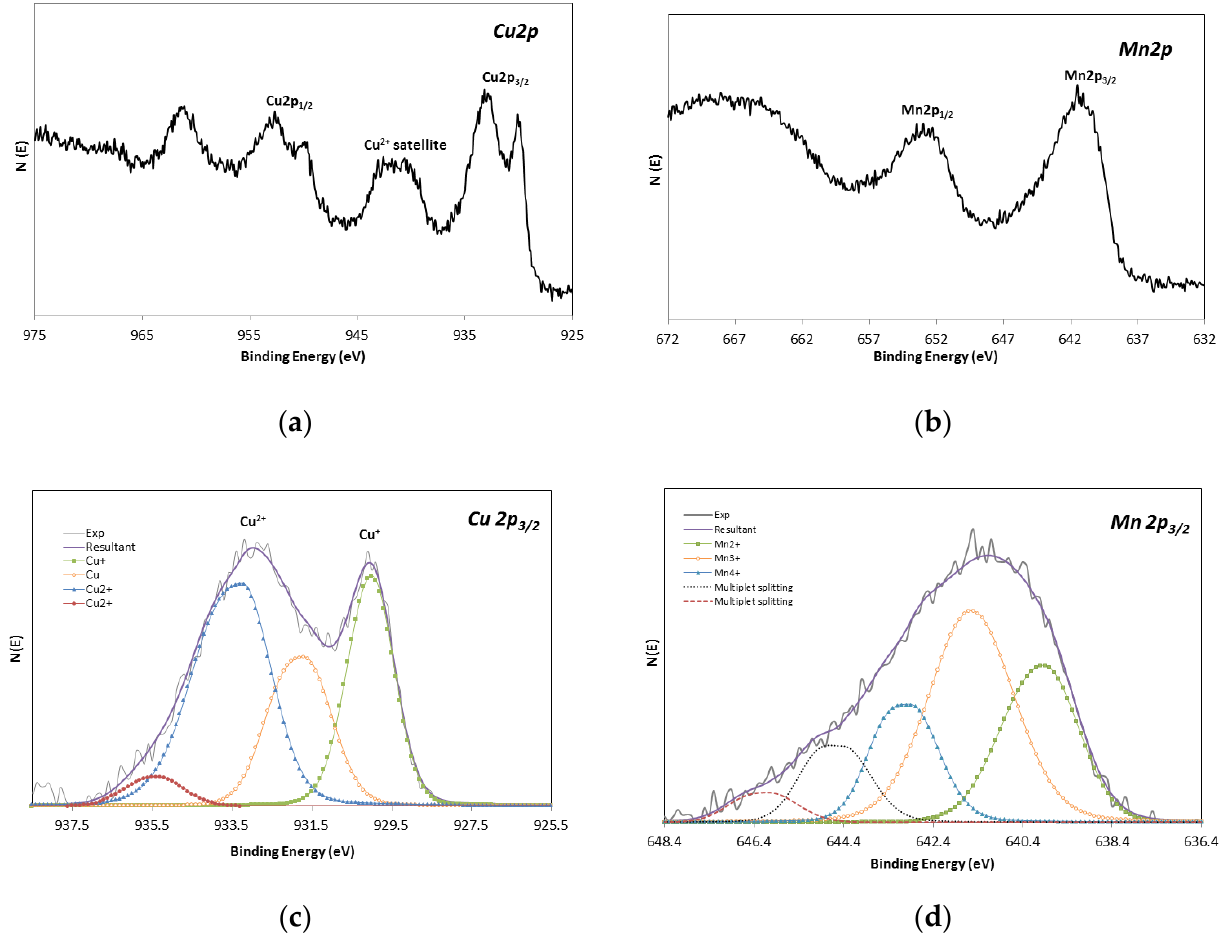
Figure 2. XPS spectra of Cu 2p ( a ), Mn 2p ( b ) and the congruent fit curves of Cu 2p 3/2 ( c ) and Mn 2p 3/2 ( d ) peaks for CuMnO x film annealed at 600 ◦ C. Table 1. Oxidation state and site distribution of copper and manganese ions in CuMnO x thin film. The percentages of Mn species were recalculated once the multiplet split components contributions (higher than 644 eV) were